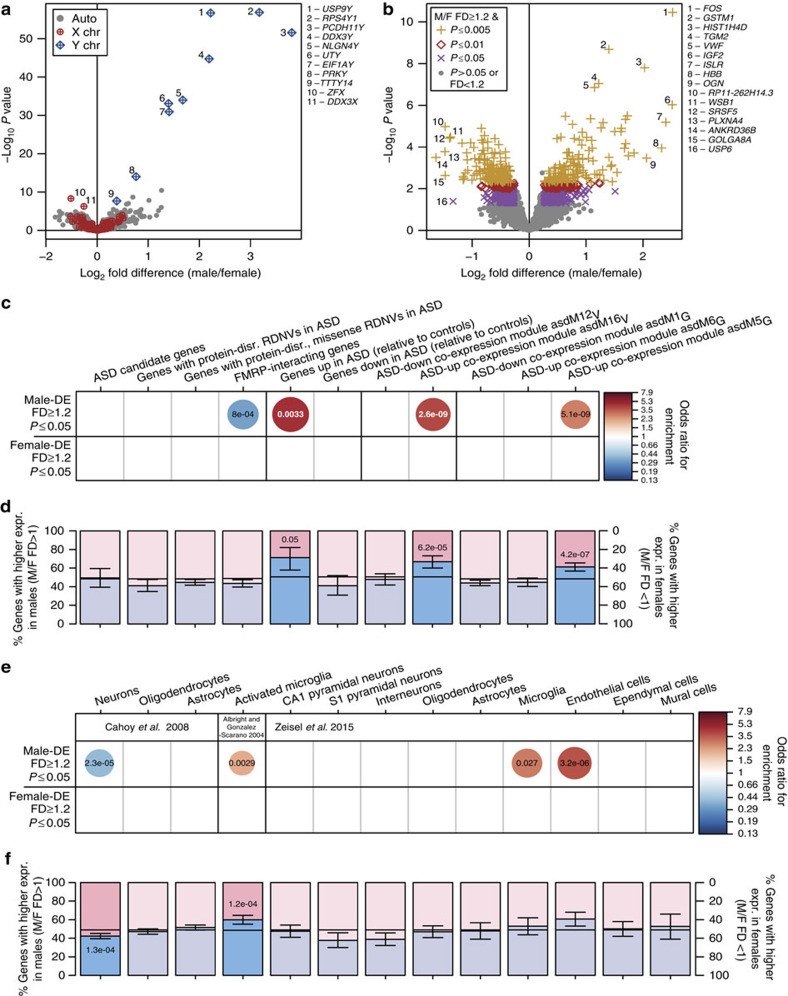
Microglia and astrocyte markers and genes upregulated in ASD brain tend toward higher expression in prenatal male brain.(a) Volcano plot for all 9,889 transcripts expressed in the prenatal sample (n male=43 samples from 4 subjects, n female=43 samples from 4 subjects). (b) Subset of the plot in a for the 9,532 autosomal transcripts. (c) Enrichment for ASD risk genes and ASD-associated gene expression patterns, and (e) neural cell type markers, within male-DE (509 genes) and female-DE (528 genes) gene sets by Fisher's exact test; circle size and colour indicate the odds ratio of all significant overlaps (Bonferroni-adjusted P value <0.05); overlaid text displays the adjusted P value for each enrichment. (d) Shifts in the distribution of sex-differential expression direction for genes in each ASD risk or ASD expression sets, and (f) neural cell type markers. Blue and pink bars display the proportions of each gene set that have higher expression in males (FD>1) or females (FD<1); whiskers note 95% confidence intervals; horizontal black lines note the proportion of male- and female-higher genes in the corresponding background gene set. Overlaid text displays significant Bonferroni-adjusted P values from the binomial test. chr, chromosome; disr., disrupting; expr., expression; F, female; M, male.